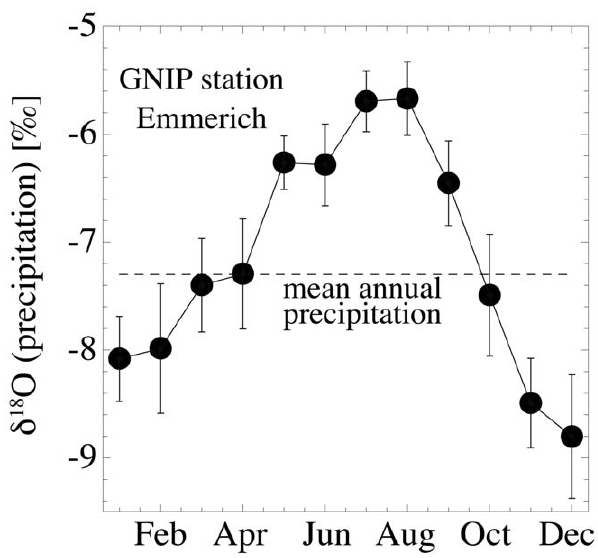
Figure 2. Mean long-term monthly d 18 O record (1980–2005) of local precipitation from the IAEA-GNIP station Emmerich.